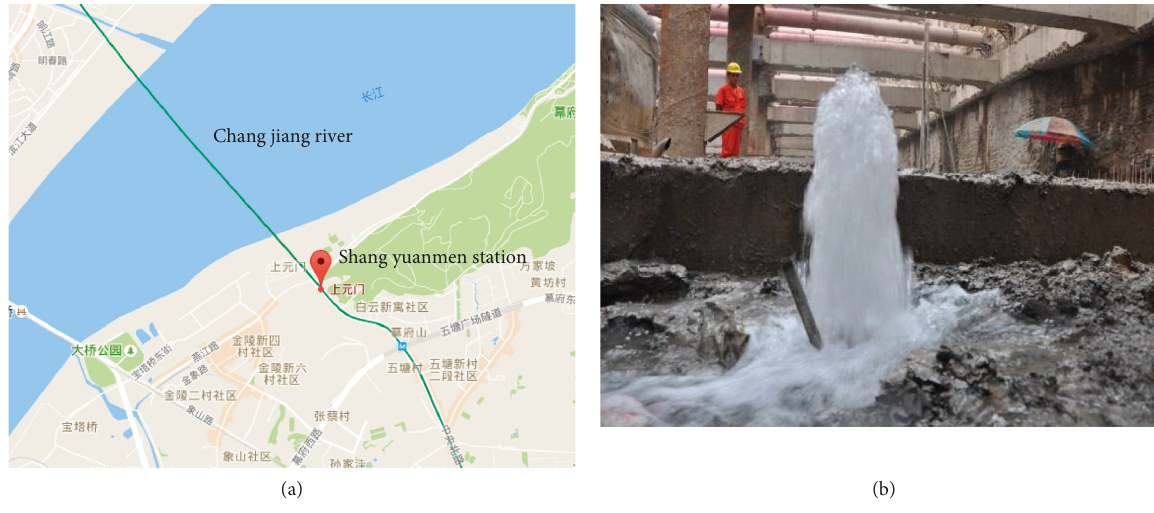
Figure 1: Station location and water inflow of Table 1: Physical and mechanical characteristics.